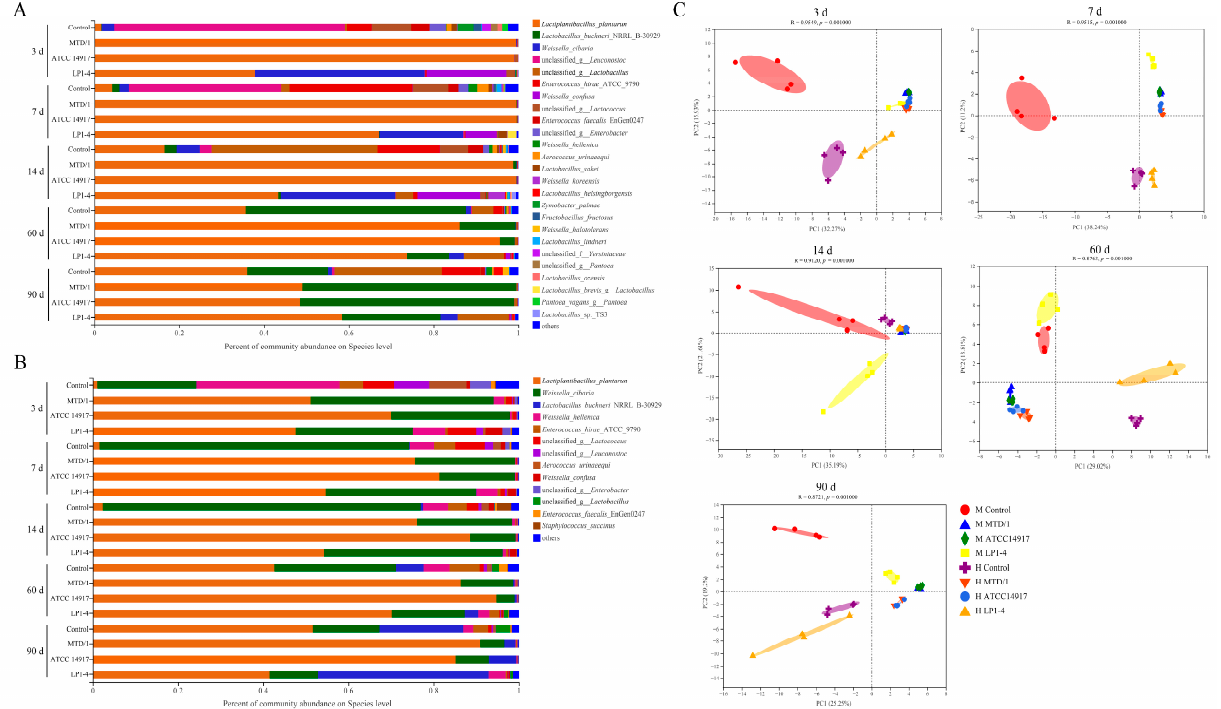
Figure 2. Dynamics of bacterial community compositions and PCA analysis of alfalfa silage during ensiling. ( A ) Relative abundances of alfalfa silage bacterial species across different groups and fermentation times at the ( A ) moderate and ( B ) high dry matter contents. ( C ) PCA analysis during ensiling. M, moderate dry matter; H, high dry matter. Control, distilled water; MTD/1, MTD/1 treatment; ATCC14917, ATCC14917 treatment; and LP1 ‐ 4, LP1 ‐ 4 treatment.